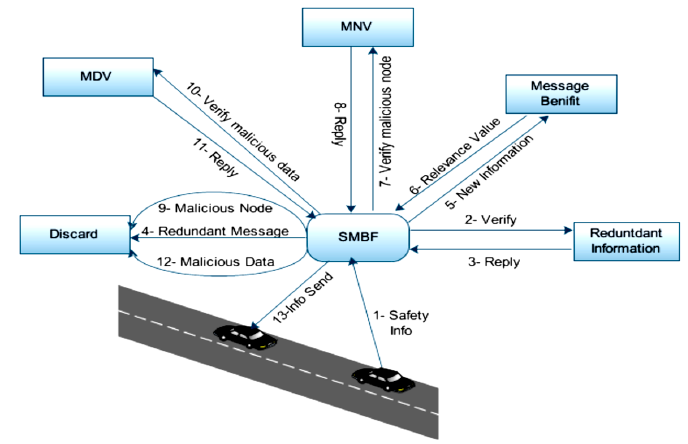
Figure 18. A representation of the Secure Multimedia Broadcast Framework (SMBP) [54].